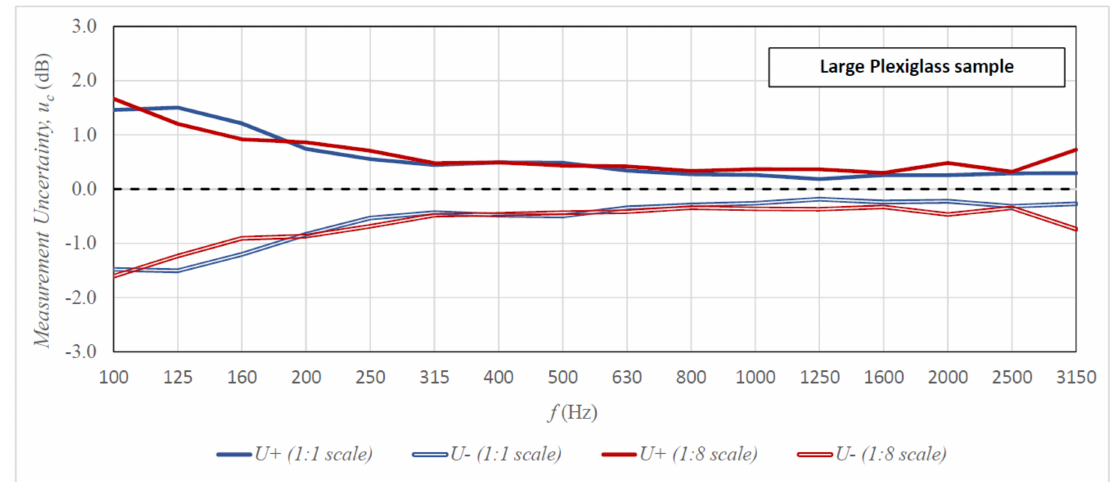
Figure 6. Uncertainty of sound insulation measurement for the 1 × 2 m plexiglass specimen (1:1 scale stand)/125 × 250 mm (1:8 scale stand) as a function of frequency for the 10-element measurement samples; the results from the scaled rooms were scaled to actual measurement frequencies.